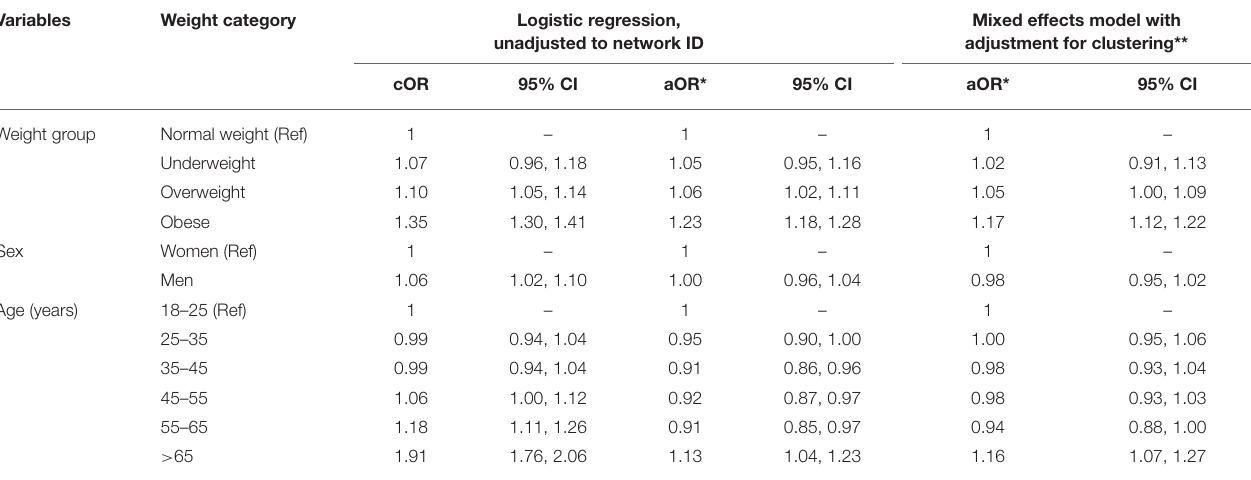
TABLE 3 | Univariable and multivariable logistic regression analyses of the association between patient’s weight category and AD prescribing among CPCSSN patients with depression, adjusted for clustering by networks. Variables Weight category Logistic regression, Mixed effects model with unadjusted to network ID adjustment for clustering** cOR 95% CI aOR* 95% CI aOR* 95%